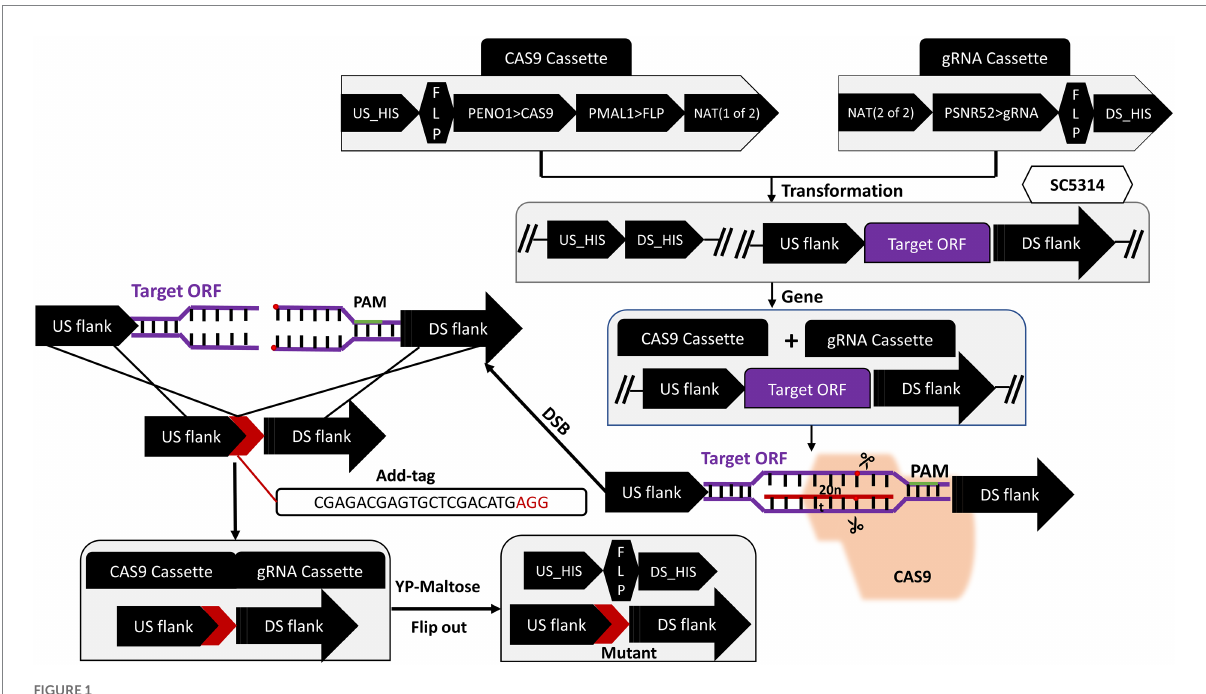
FIGURE 1 Schematic diagram of target gene knockout